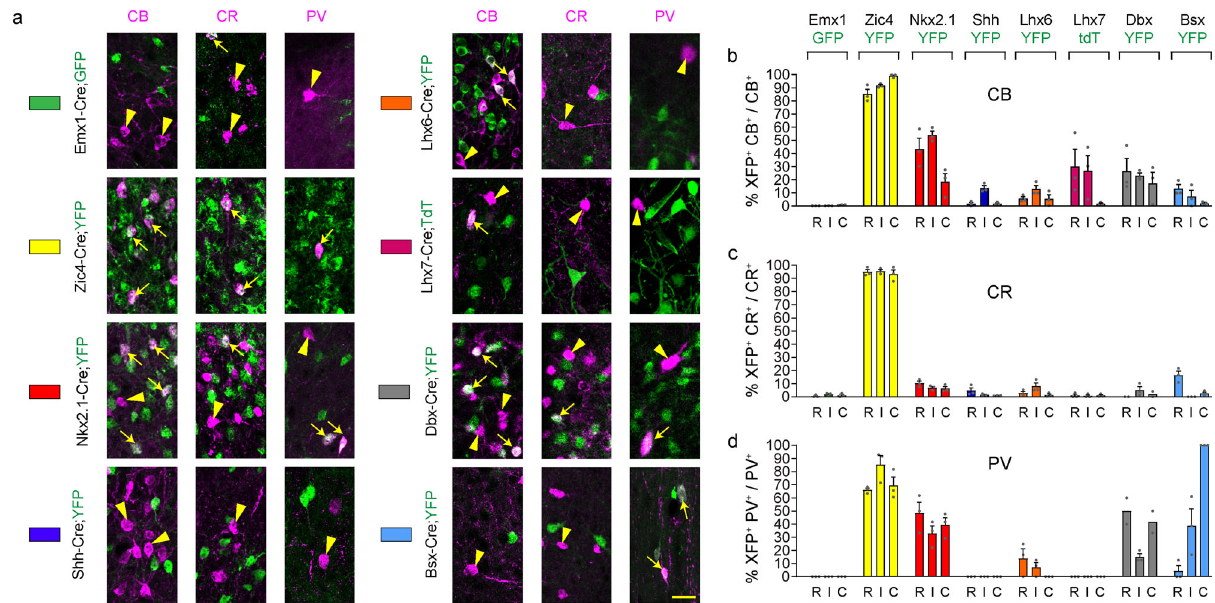
Fig. 3 Septal embryonic origins of lateral septal neurons. a Contribution of different forebrain domains to LS populations. Double-labelling for CB, CR or PV and the fl uorescent reporter protein GFP/YFP/TdT in the various transgenic lines at P30. White arrows and arrowheads indicate double and single labelled cells, respectively. b – d Histograms showing the percentage of neurons double labelled for GFP/YFP/TdT over the total population. Each transgenic mouse line is identi fi ed by a different colour as shown in a and as summarised in Fig. 2d, e. n = 3 brains per transgenic line per marker except the following where n = 2 for Dbx-Cre;YFP mice: CR R and C, PV R and C. Histograms show mean + SEM. Source data are provided in Supplementary Data 1. Scale bar: 25 μ